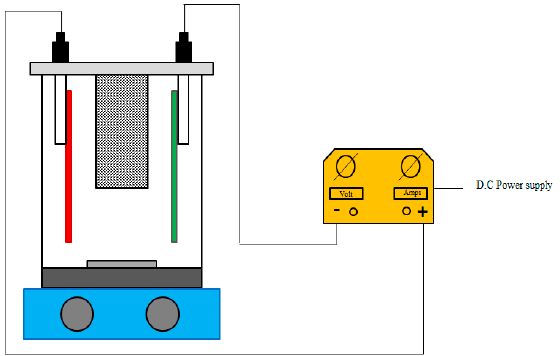
Figure 1. Schematic diagram of the three-dimensional electrode batch reactor.